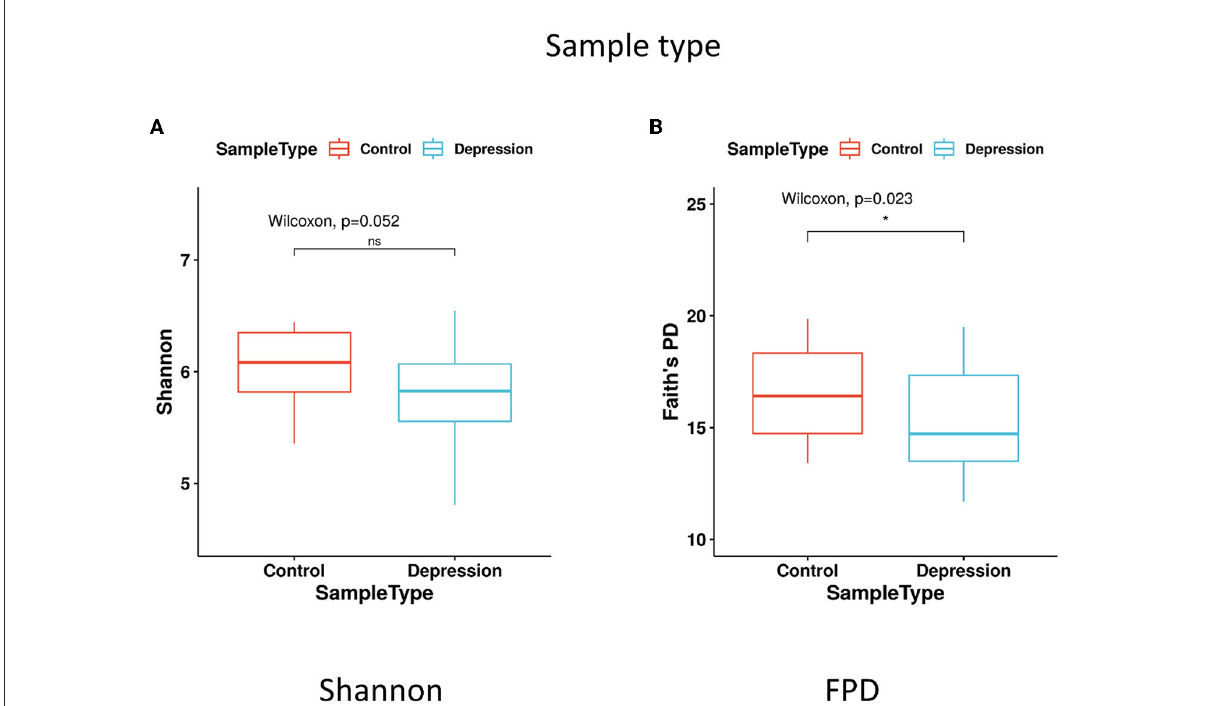
FIGURE2 α -diversity in fecal samples shown as boxplots. α -diversity, measured by (A) Shannon diversity index and (B) Faith’s phylogenetic diversity (FPD), is plotted for patients with late-life depression (LLD) (blue) and controls (red). The thick line inside the box represents the median, while the whiskers represent the lowest and highest values within the 1.5 interquartile range (IQR). The Wilcoxon rank-sum test shows that FPD is significantly decreased in depressed patients compared to controls. * p < 0.05 by Wilcoxon rank-sum